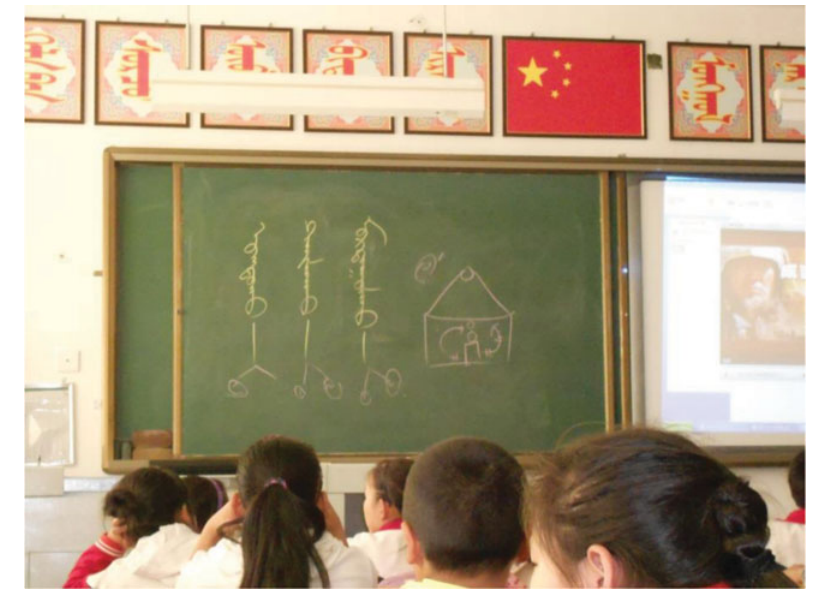
FIGURE 4 (Colour online) Track 2 in the Bilingual